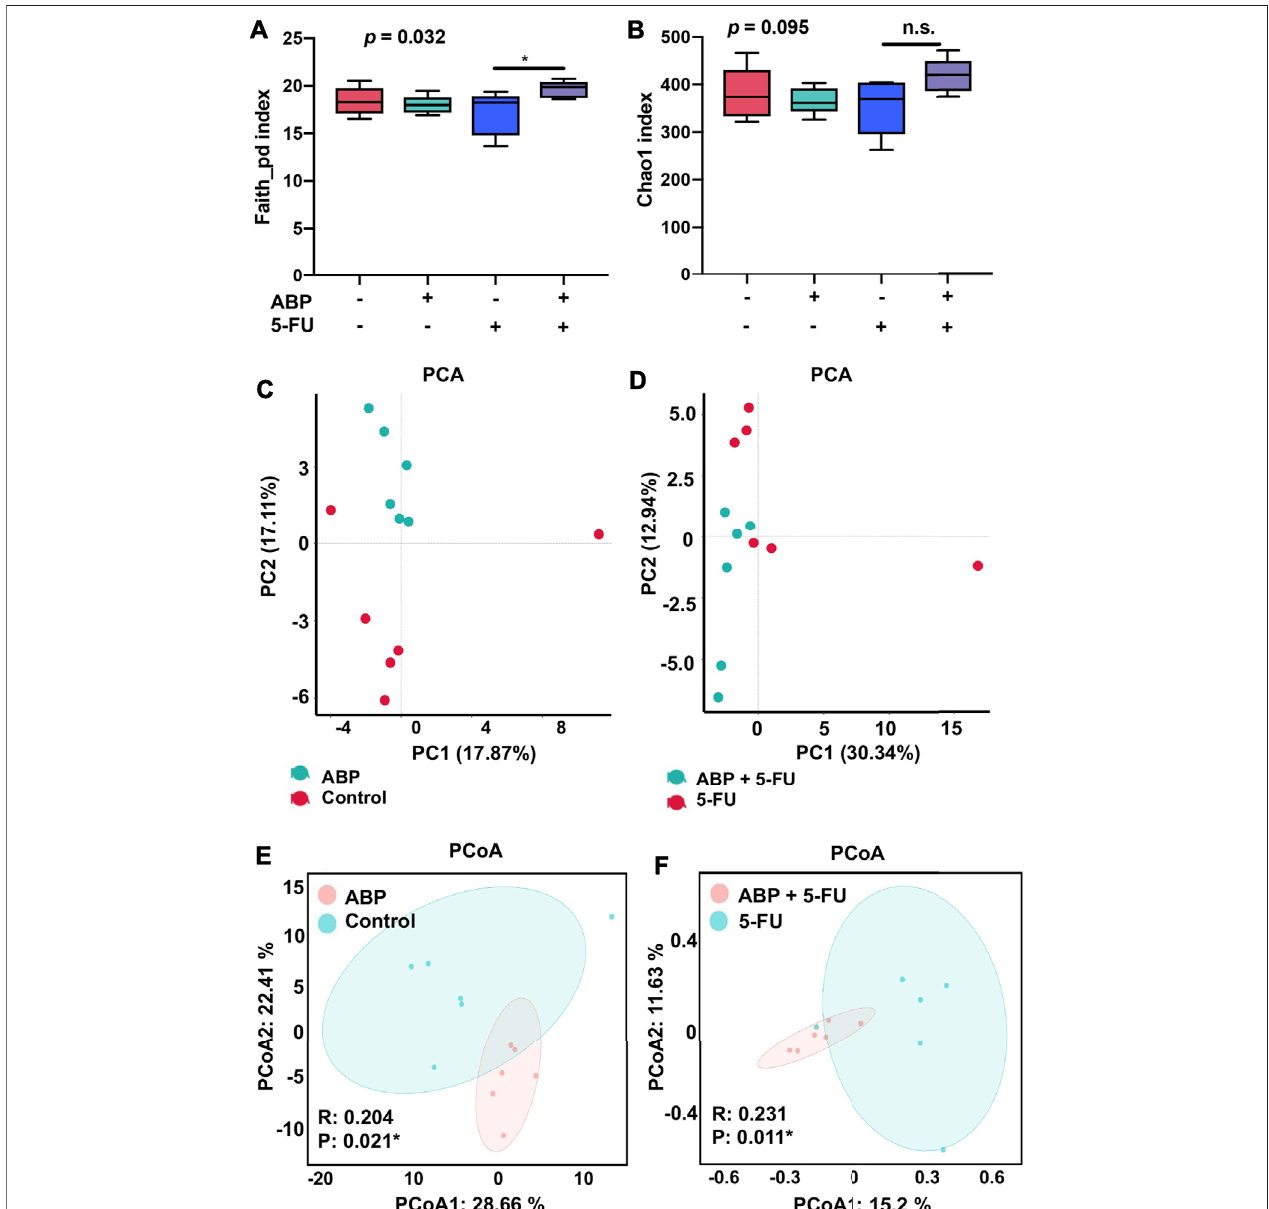
FIGURE 6 | ABP treatment alters the abundance and diversity of gut microbes in mice bearing CT26 tumors. (A-B) Analysis of alpha diversity; (A) Faith_pd index. (B) chao1 index. (C-F) Analysis of beta diversity. (C-D) Principal components analysis (PCA). (E-F) principal coordination analysis (PCoA) (n (cid:2) 6 mice per group).